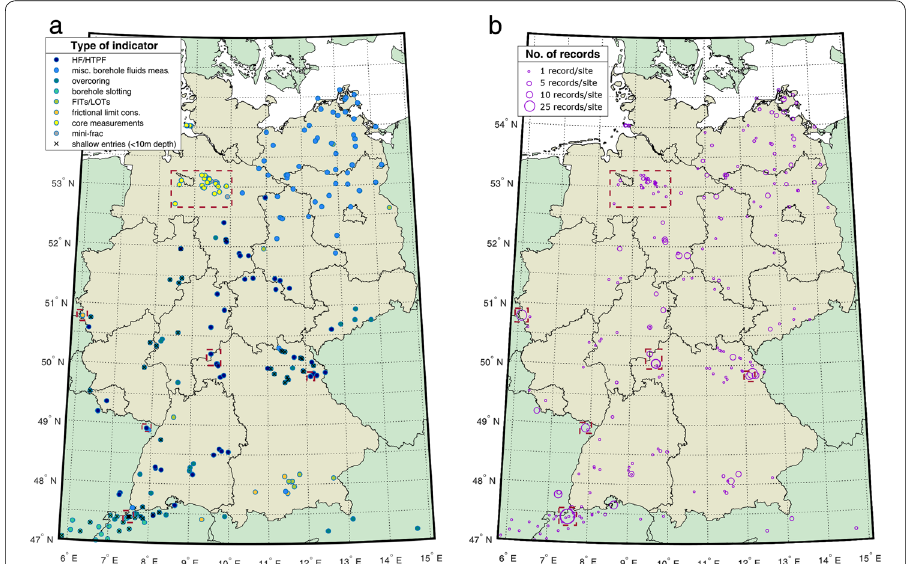
Fig. 5 Locations, stress magnitude indicators and number of data records. Examples discussed in more detail are marked by dashed boxes. Plotted are all data records for which depth information is available ( n a Assigned indicator types illustrated by colour. Very shallow records (<10 m below surface) are additionally marked with a cross. The colour code corresponds to that used in Figs. 6 and 7. b Number of data records per site illustrated by circle diameters. The term site refers to the same latitude–longitude